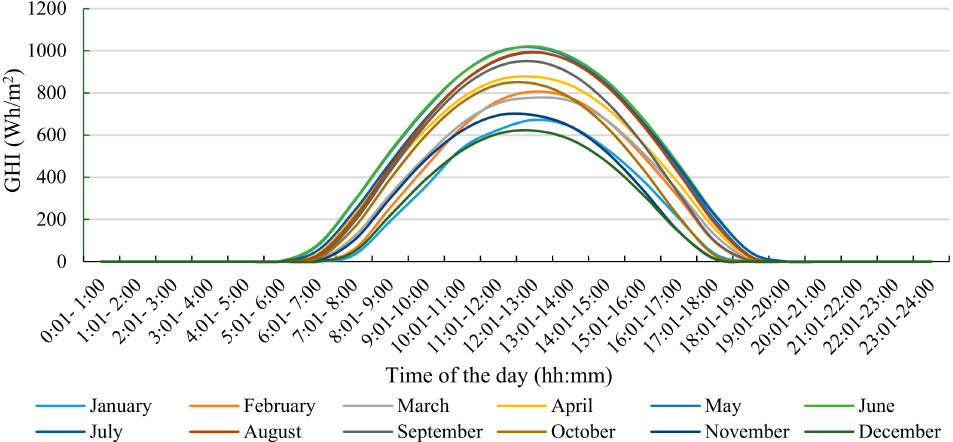
Figure A1. Monthly hourly average solar global horizontal irradiation (GHI) in Abu Dhabi, UAE (24 ◦ 28 (cid:48) N 54 ◦ 22 (cid:48) E), based on the TRNSYS database (TMY2)